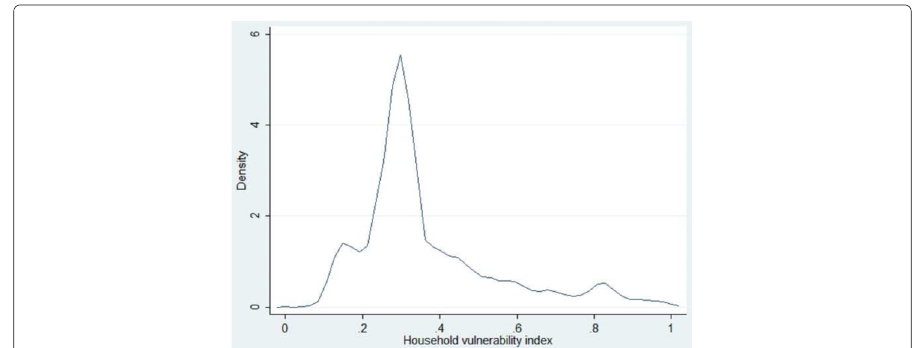
Fig. 2 Kernel density household vulnerability